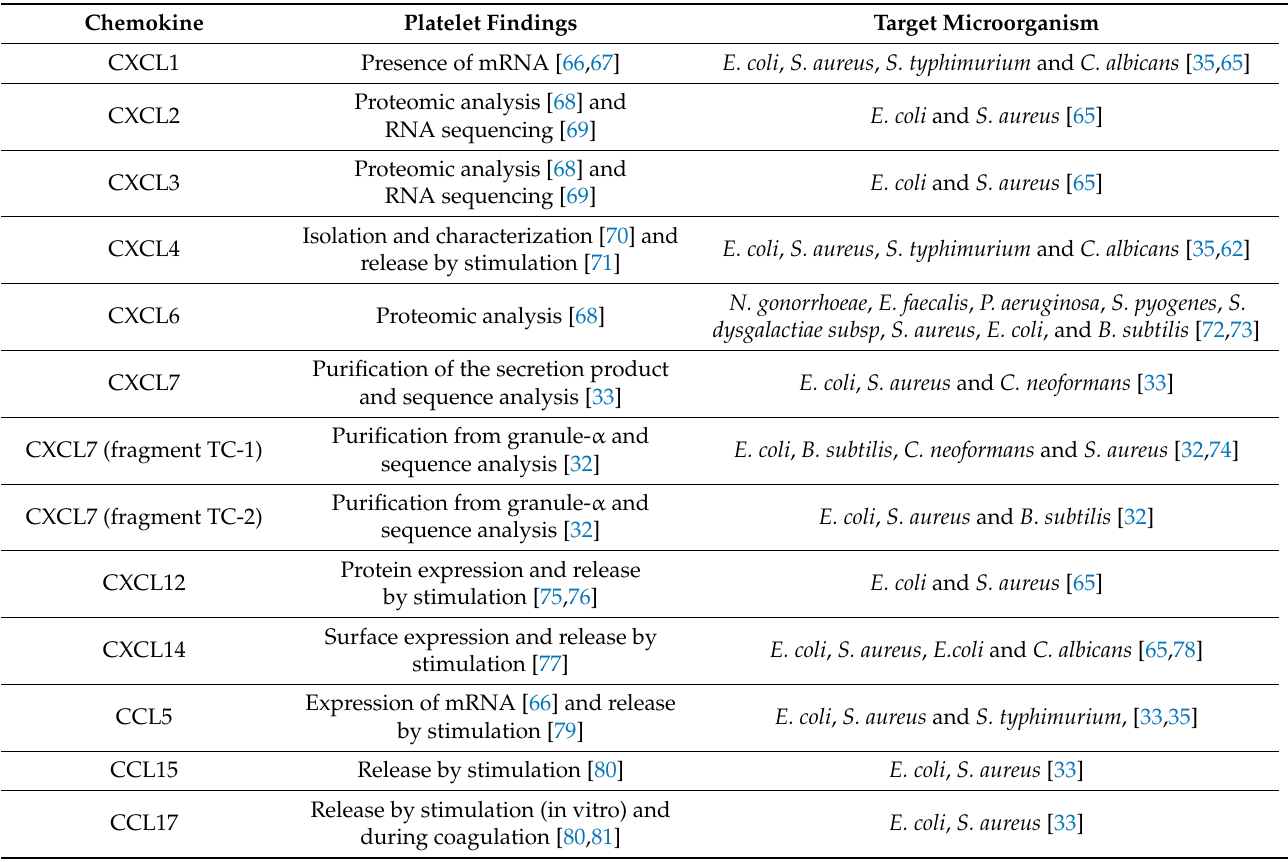
Table 1. Kinocidins in human